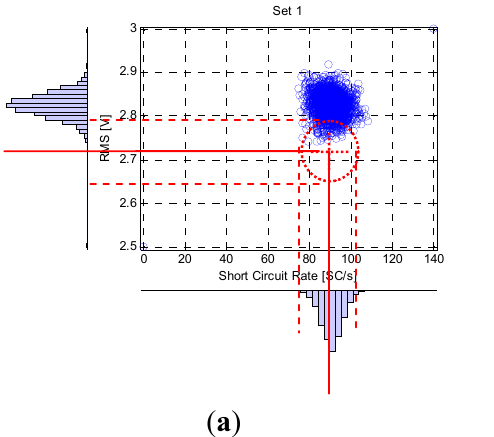
Figure 5. Distribution of RMS and Short circuit rate